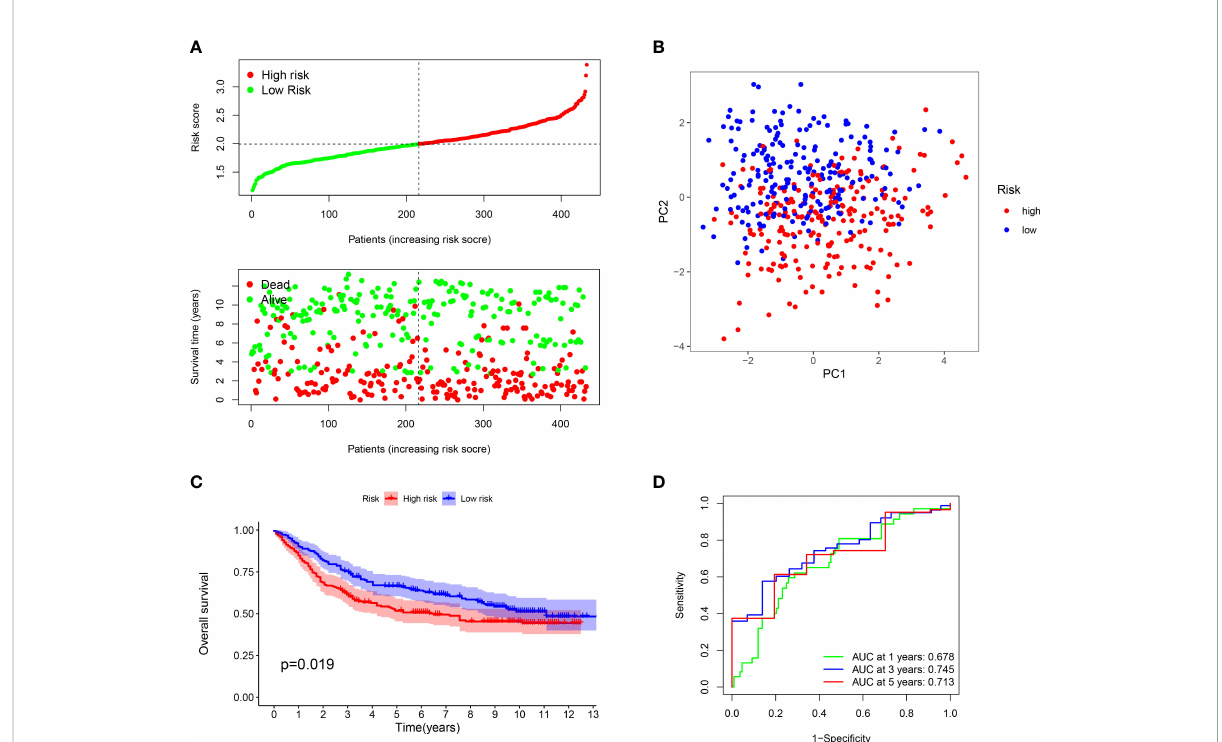
FIGURE 3 Evaluation of prognostic effect in GEO dataset. (A) Distribution of risk scores for each GC sample and survival time and status for each GC sample based on risk scores. (B) The PCA analysis of GC patients between high and low risk groups. (C) Survival differences between GC patients between high and low risk groups. (D) ROC analysis of GC